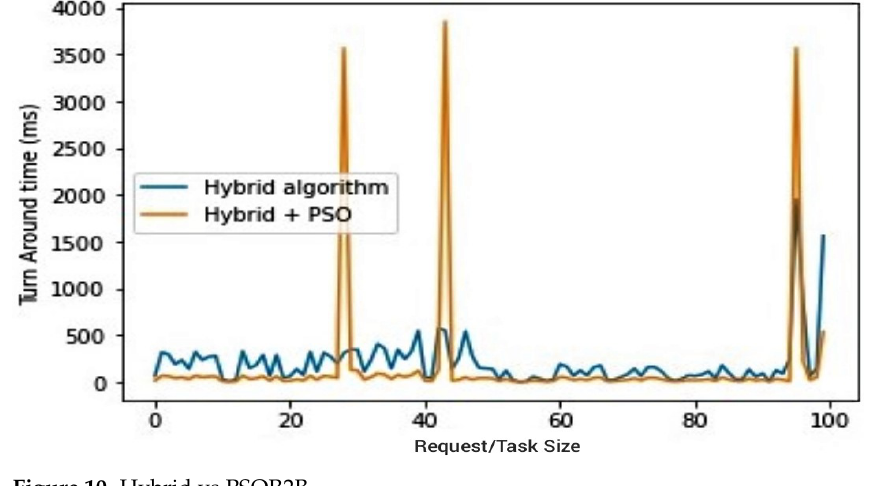
Figure 10. Hybrid vs PSOR2B.